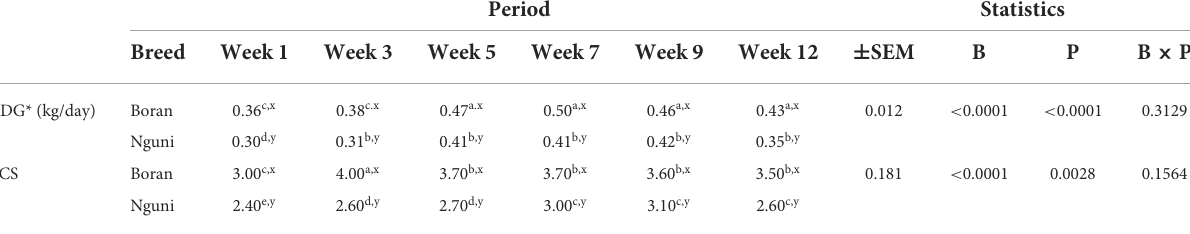
TABLE 3 LSMeans for the average daily gain (ADG) and body condition scores (BCS) according to breed and observation period. Period Statistics Breed Week 1 Week 3 Week 5 Week 7 B × P ADG* (kg/day) Boran